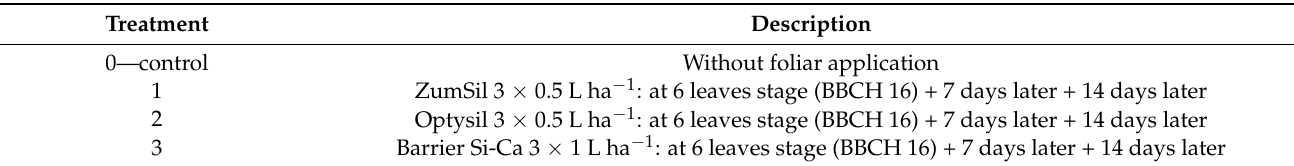
Table 2. Treatments used in the experiment (2017–2019).